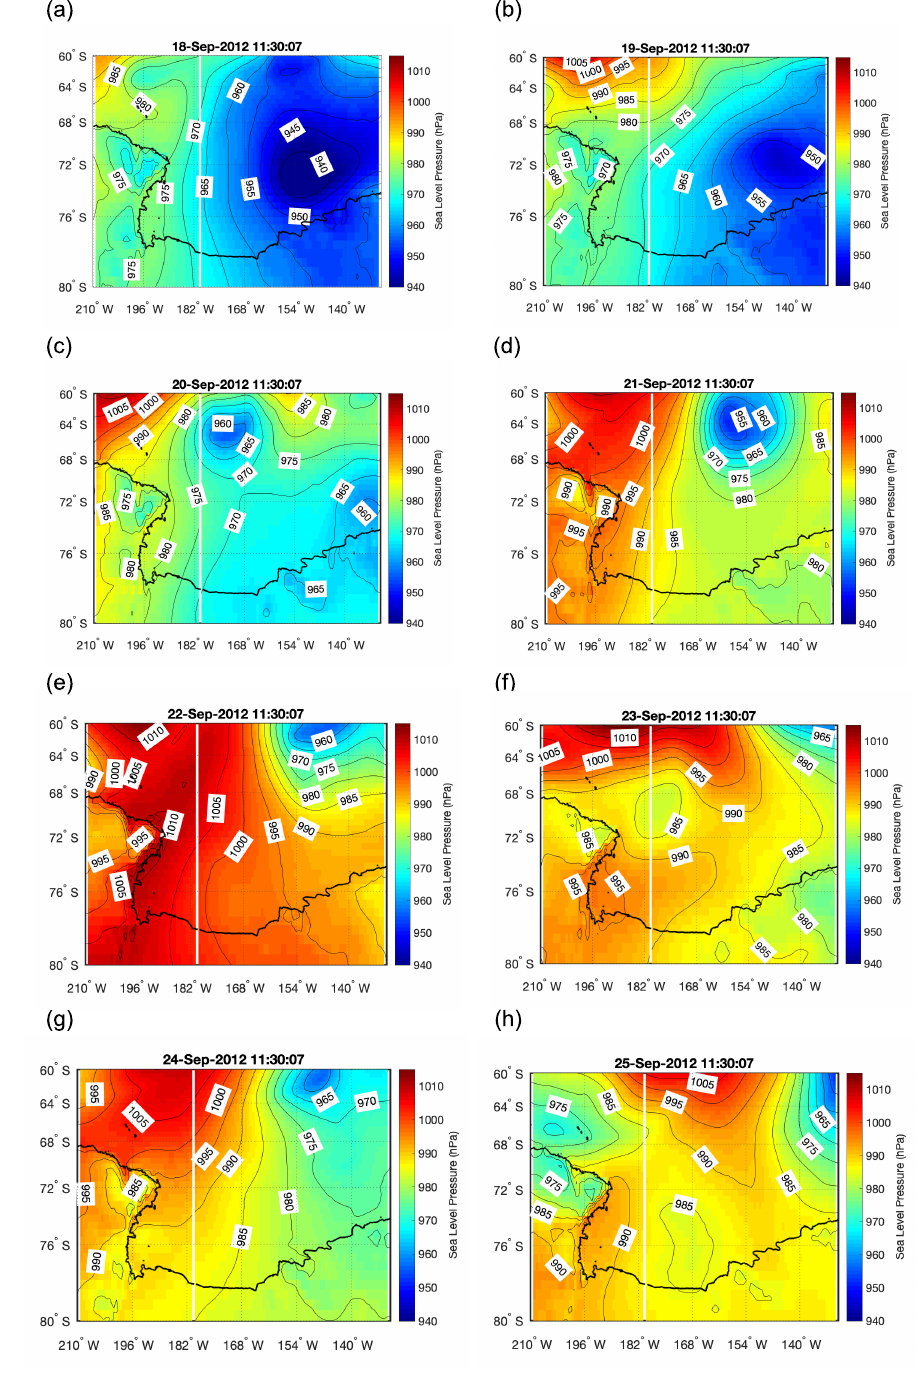
Figure 3. Sea level pressure maps for the Ross Sea area from MERRA dataset. Every image represents situation from a single hour of 11:30 a.m. on a consecutive days between 18 and 25 September 2020 ( a – h